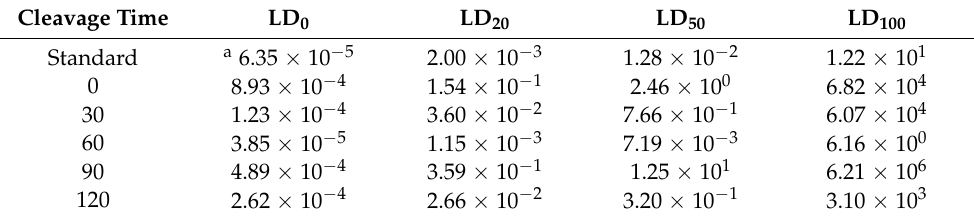
Table 5. Lethality response for products from various cleavage intervals (unit: mg/L).